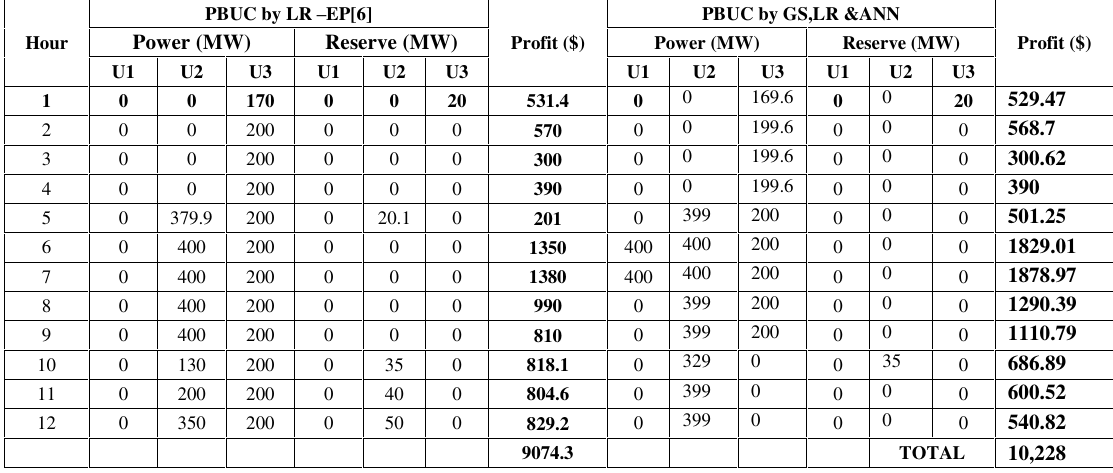
Table VI Power and reserve generation of reserve payment method B (r=.005, reserve price =.04 x spot price)